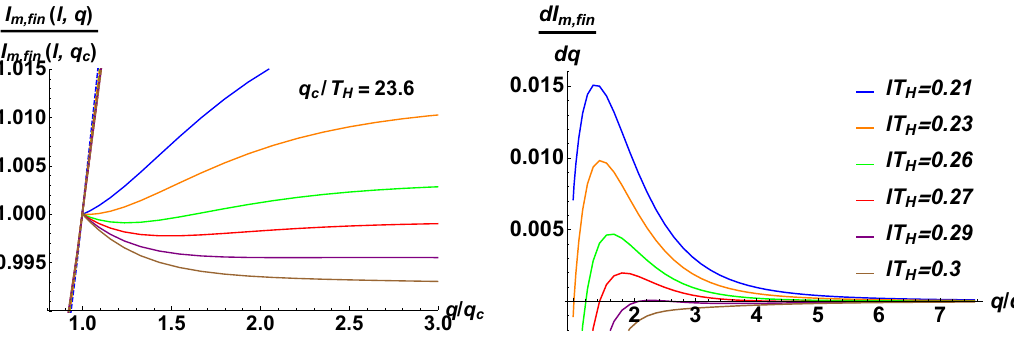
= 50. We plot the YM